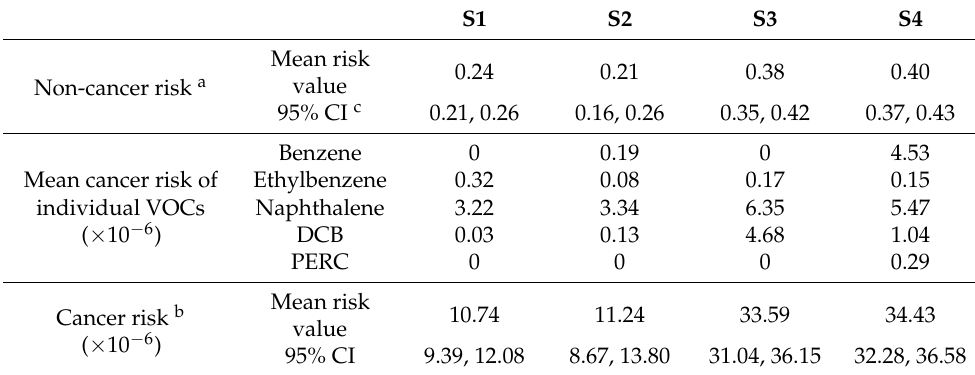
Table 3. Non-cancer and cancer risks of exposure to VOCs in the investigated schools.